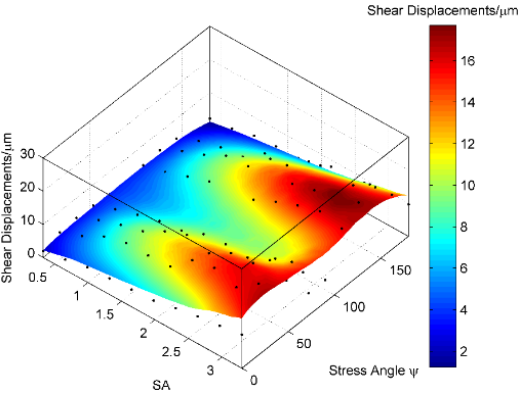
Figure 15. The variation of shear displacements with ψ and SA. The result of each simulation is represented by a black point. The smoothed value is represented by the colored surface.